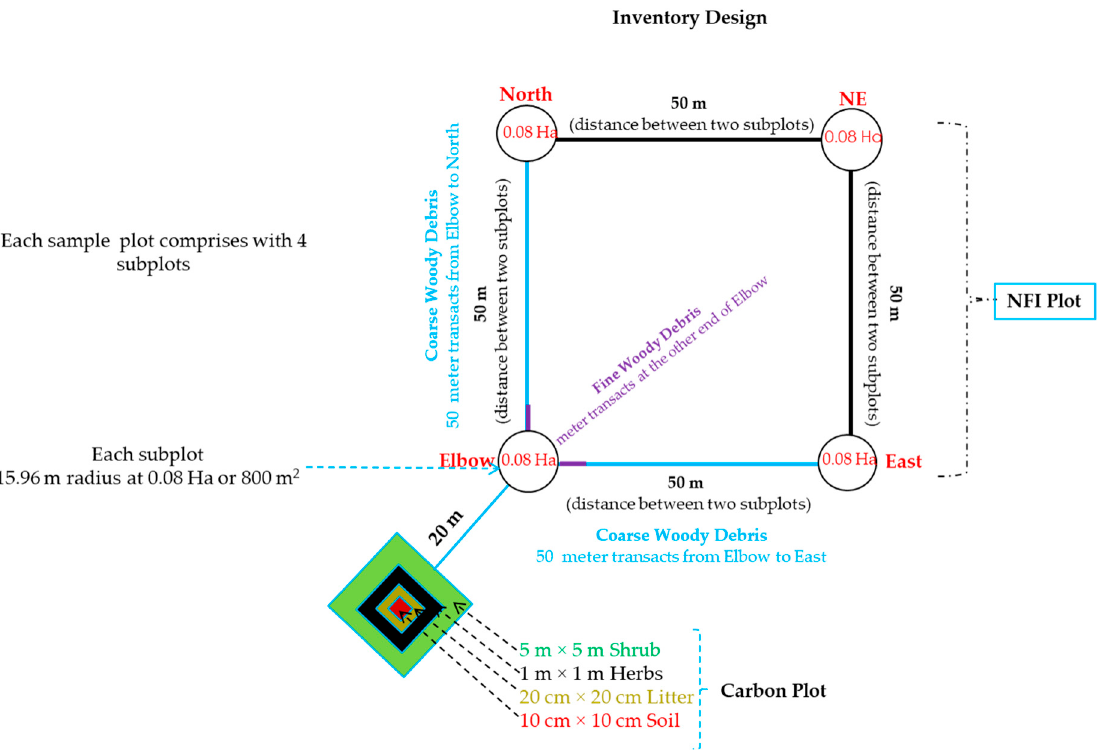
Figure 4. Field forest inventory sampling design in Myanmar. Source: Planning and Statistics Division, Forest Department of Myanmar.